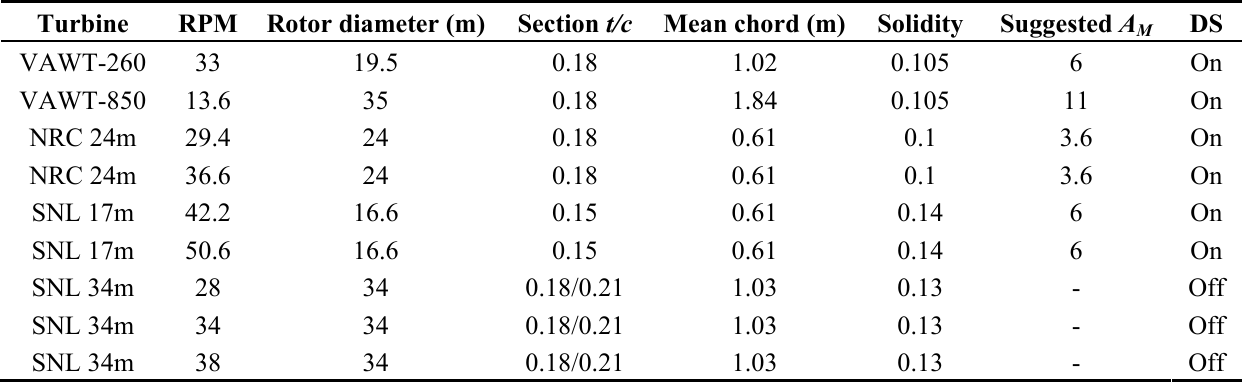
Table 1. Dynamic stall parameters recommended for different